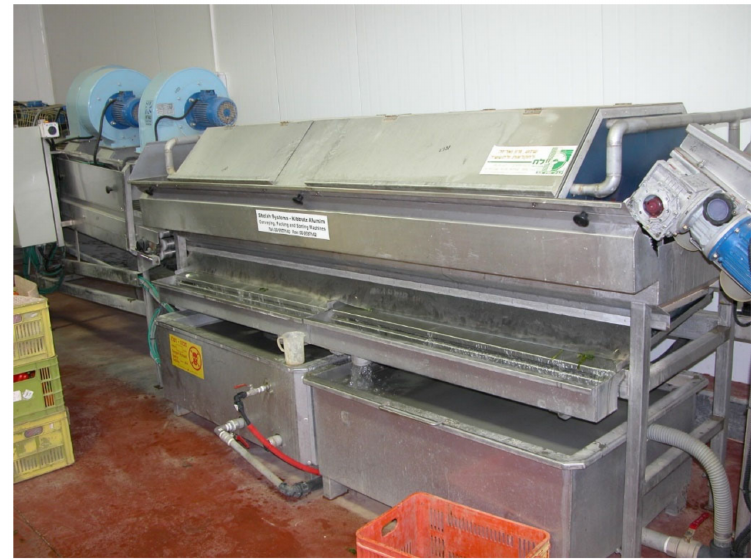
Figure 4. Fifth version, 2005 (photo by E.